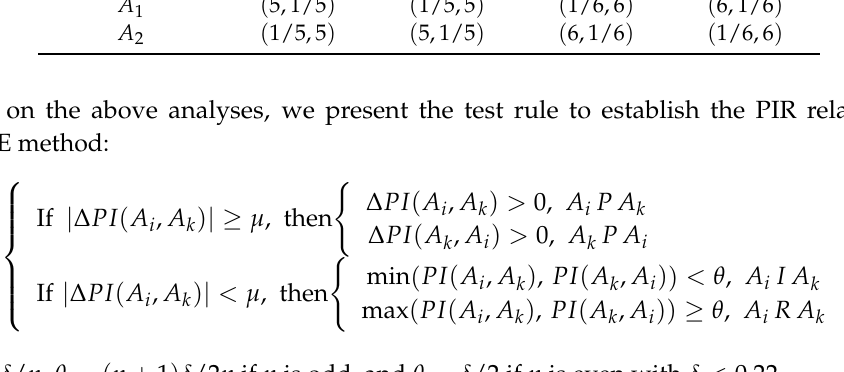
Algorithm 2 (The IM-ORESTE